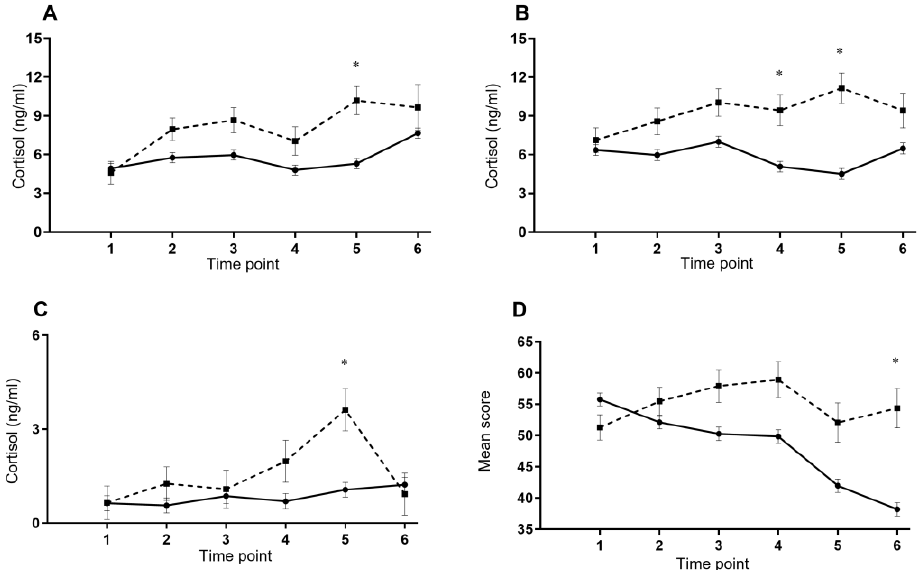
Figure 1. Mean ( ± SEM) changes in ( A ) waking cortisol concentration, ( B ) 30 min post-waking cortisol concentration, ( C ) bedtime cortisol concentration, ( D ) NASA-TLX six-subscale average during the first 6 weeks of BMT between those who completed BMT on time (ON-P; solid line; — ) and recruits who did not (OFF-P; dashed line; - - -) * p < 0.05.